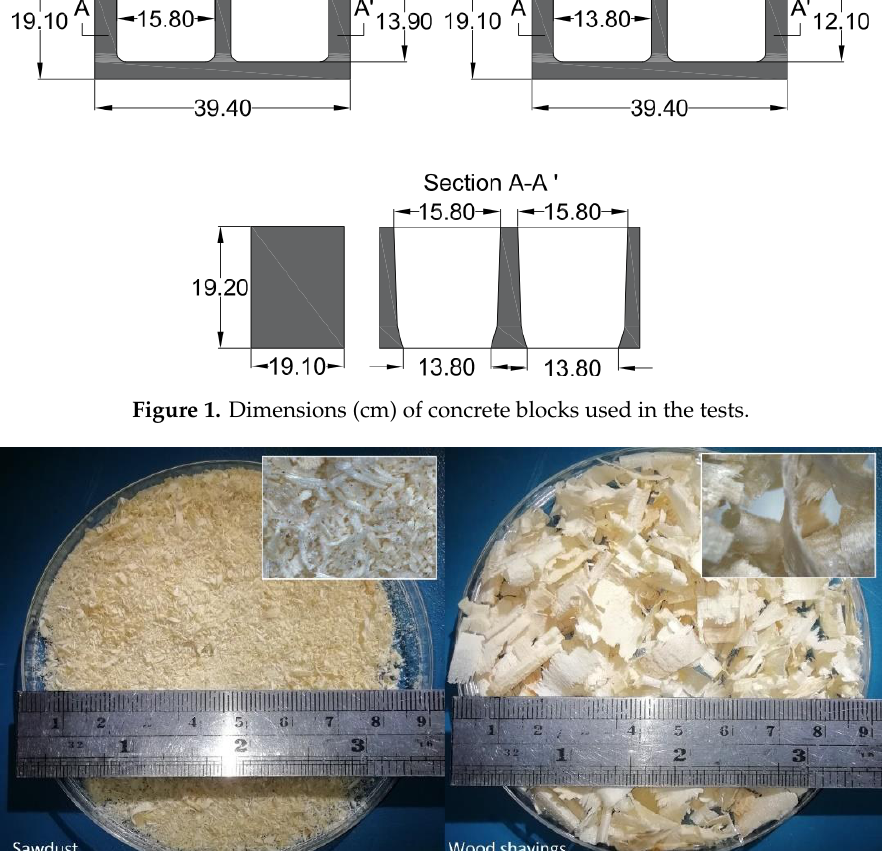
Figure 1. Dimensions (cm) of concrete blocks used in the tests.